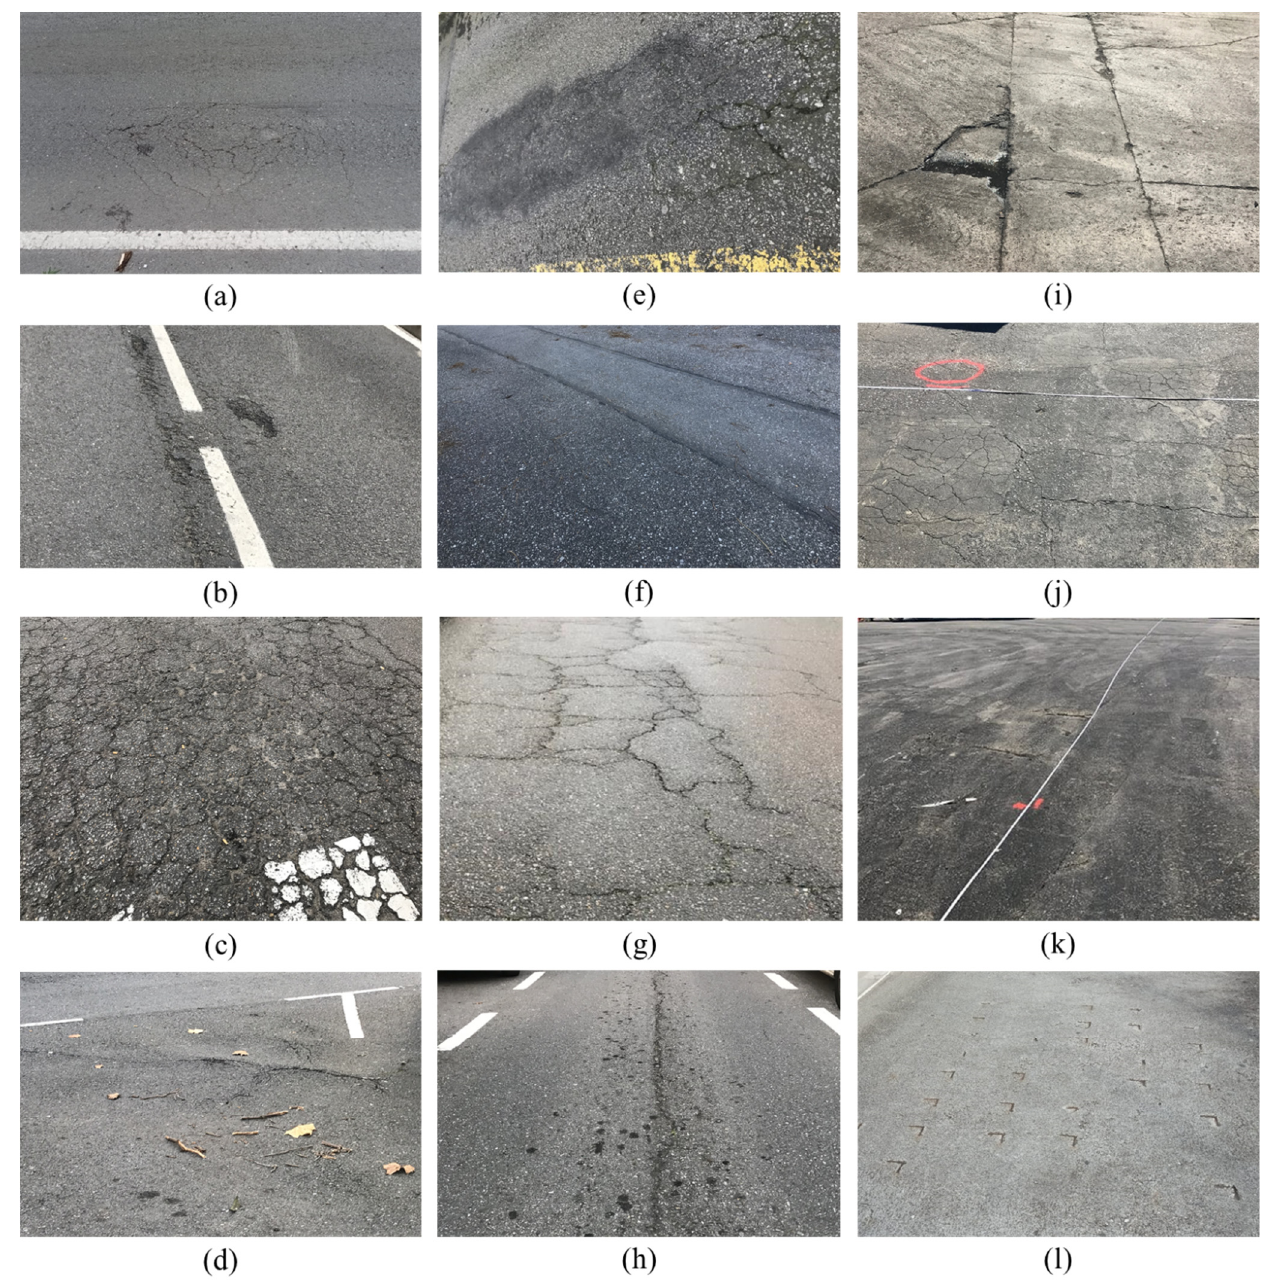
Figure 2. Examples of superficial distresses in both flexible ( a – h ) and rigid ( i – l )